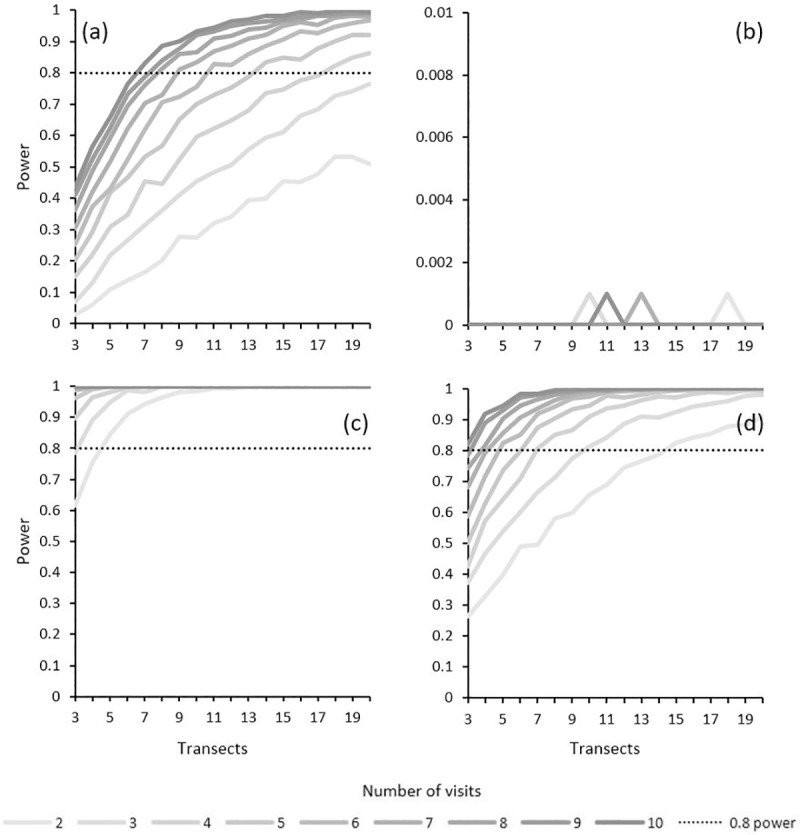
The power to detect a significant (p < 0.05) change in B. robustus population size with increasing number of transects and repeated visits using adult female data collected in November and December at (a) Patersons Terrace, and (b) Snowy River, and total population (any age or sex) data collected in February (as per historical monitoring methods for B. robustus) at (c) Patersons Terrace, and (d) Snowy River. Female grasshoppers with a femur length ≥15 mm were considered to be adult. Excludes grasshoppers less than 8 mm in body length.